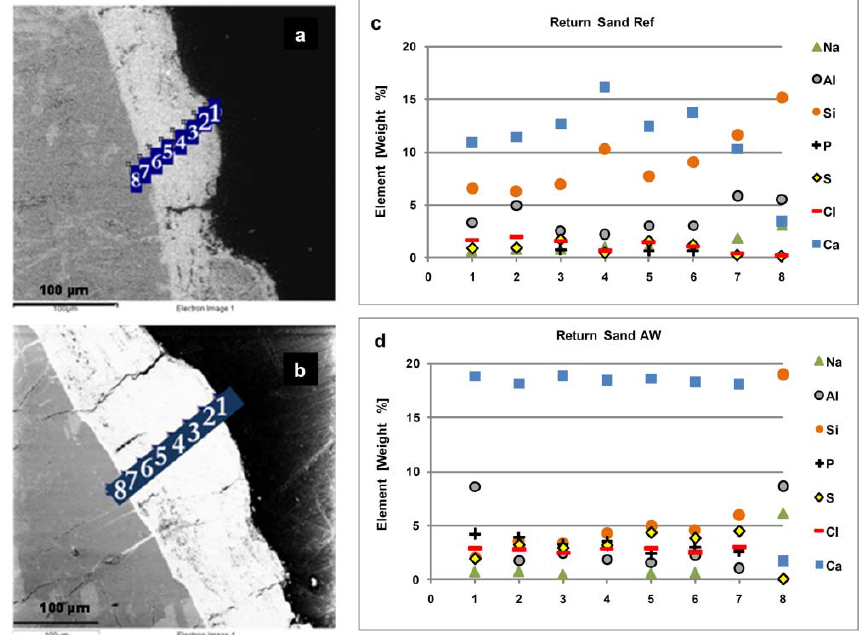
Figure 6. Cross-sectional SEM-EDX spot analysis of the coated return sands: ( a ) and ( c ) for the Ref case; ( b ) and ( d ) for the AW case.